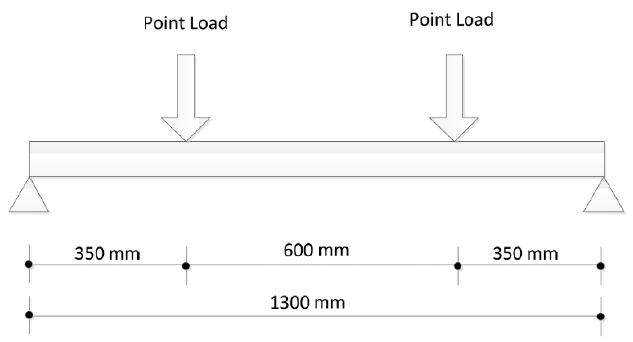
Figure 4. Geopolymer concrete beam cured in seawater for 28 days.